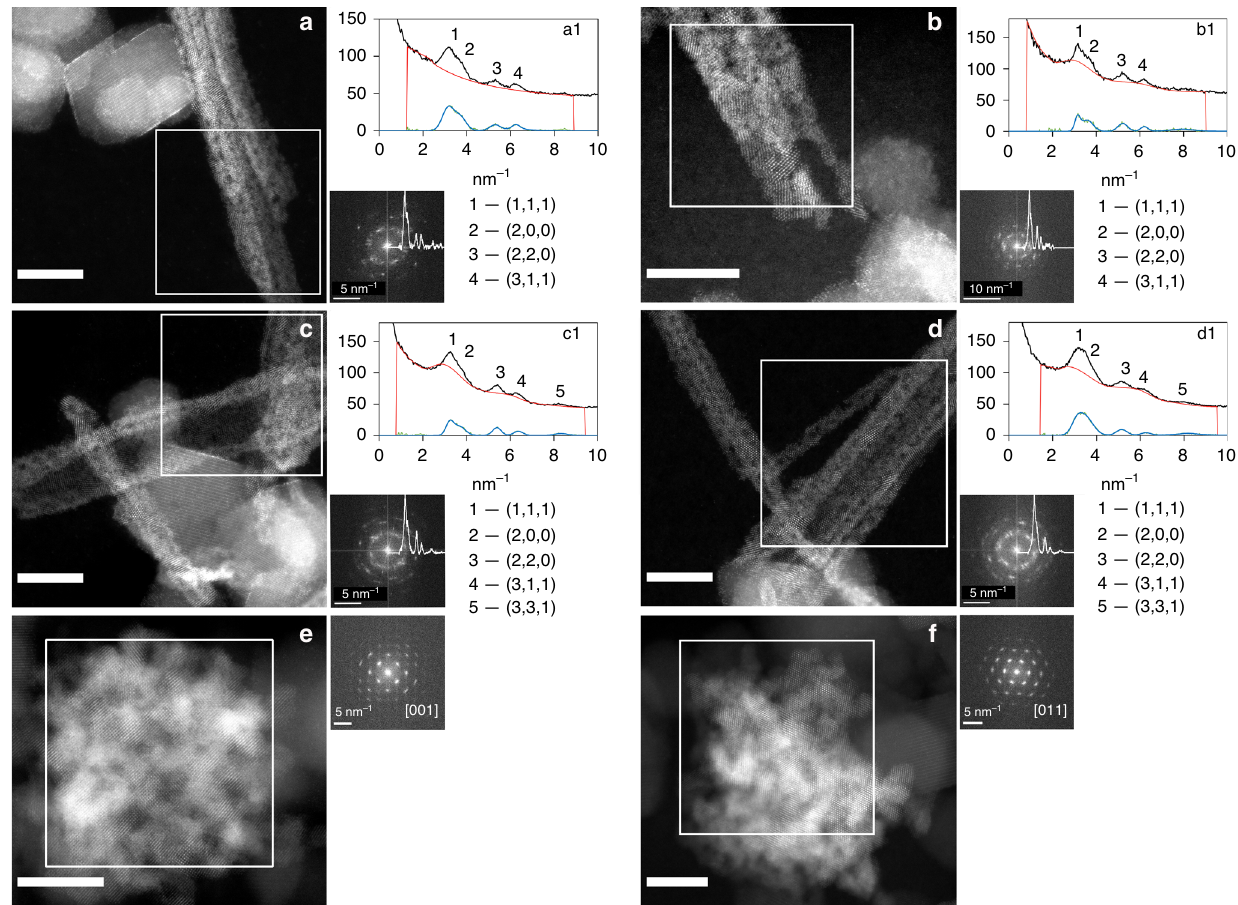
Fig. 5 Scanning transmission electron micrographs of U-magnetite samples. a , b 24-h, c , d 72-h, and e , f 4-week samples and the corresponding FFT acquired from the white square box in each panel (high-angle annular dark- fi eld scanning transmission electron microscopy image scale bar = 10 nm). Panels a1 , b1 , c1 and d1 show radial distribution pro fi les 73 of the region delineated by white squares in a – d , to con fi rm the assignment to UO 2 . Black spectra represent the acquired radial distribution pro fi les; the green pro fi les are background-subtracted while the blue ones are fi tted by Gatan DigitalMicrograph ® software (green and blue pro fi les are very similar and can appear to be indistinguishable). The d -spacings obtained from the radial distribution pro fi le were compared to those of a UO 2 standard in Supplementary Table 2. For the 4-week sample, e and f represent well-oriented bright phase nanoclusters that were composed of uraninite nanoparticles in the [001] and [011] zone axes. Panel d was also displayed in Fig.